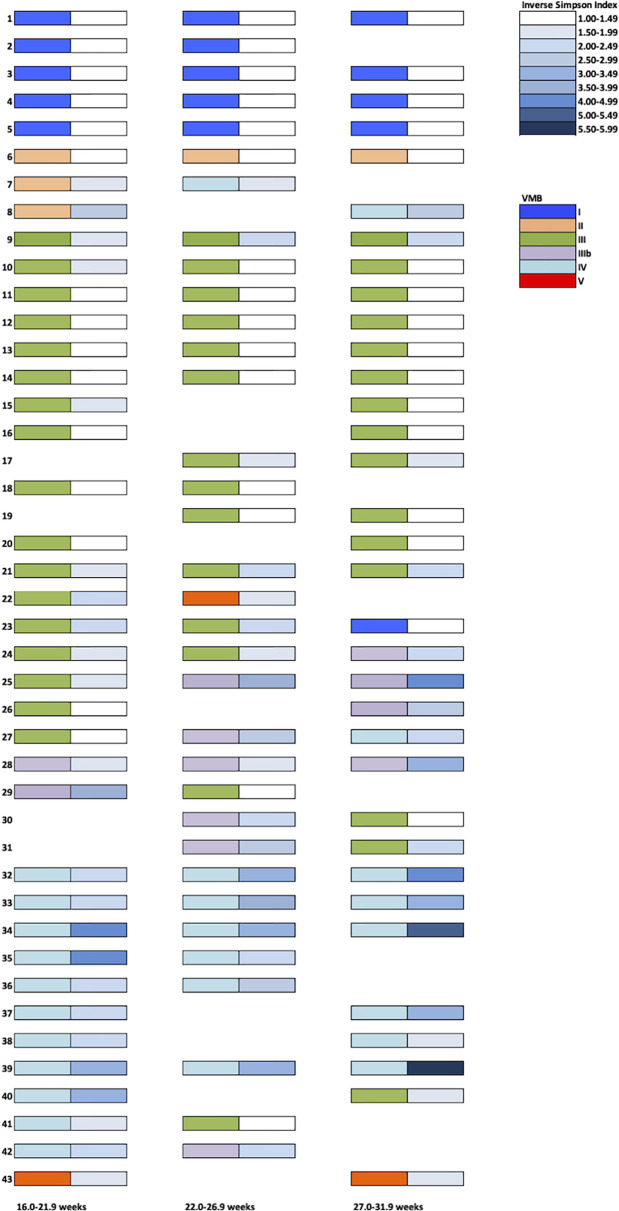
Vaginal Microbiota Group (VMB) profiles throughout pregnancy in a UK PWLWH cohort. Each sample was assigned a VMB indicated by the left-sided coloured rectangles. Corresponding Inverse Simpson Indices are presented on the right-side (white- low diversity and dark blue- high diversity).